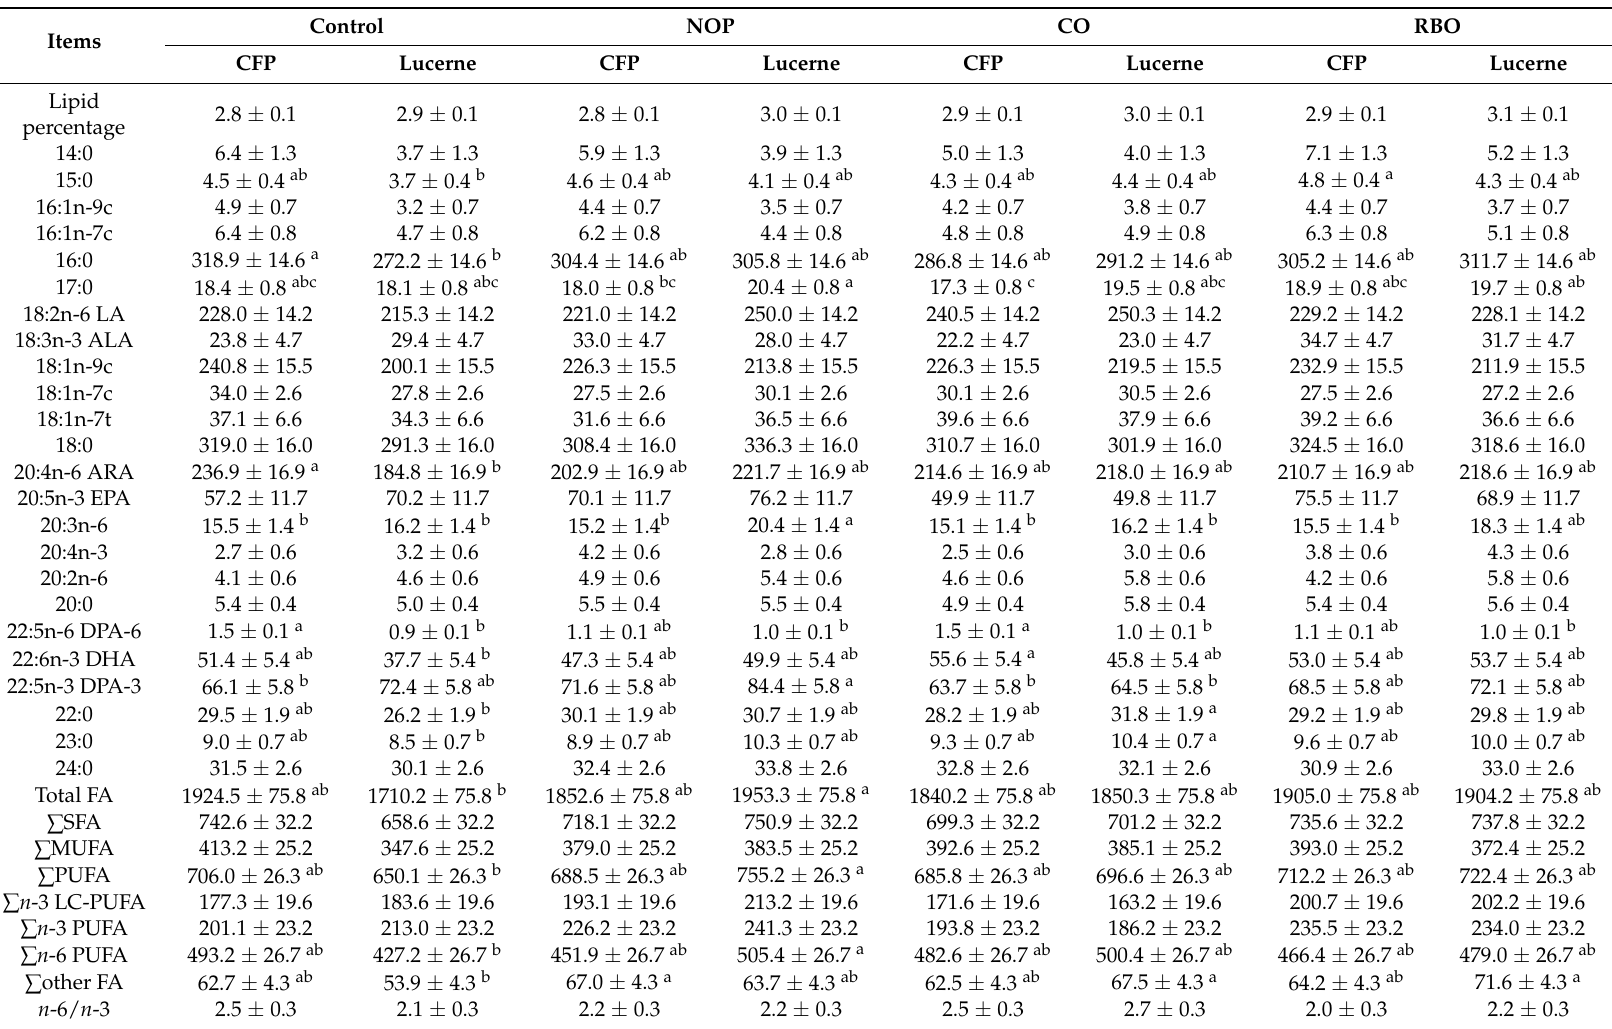
Table 6. Effect of pellet supplementation on total lipid percentage (g fat/100 g) and fatty acid contents (mg/100 g) in kidney of grazing prime lambs (LSM ± SE)